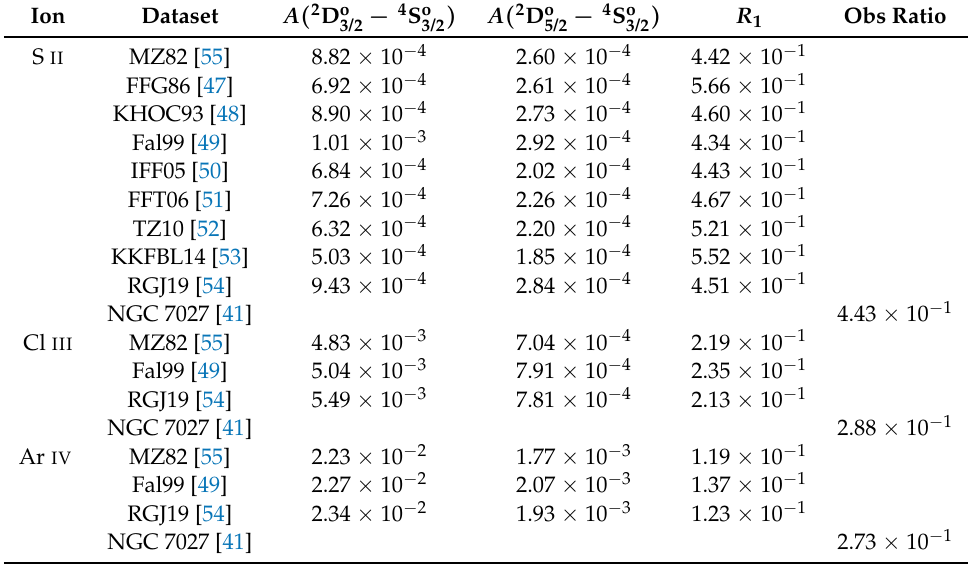
Table 2. Theoretical A -values (s − 1 ) for the 2 D o configuration of P-like S II , Cl III , and Ar IV . The R 1 ratio is also given for comparison with the line-intensity ratio observed in the dense NGC 7027 planetary